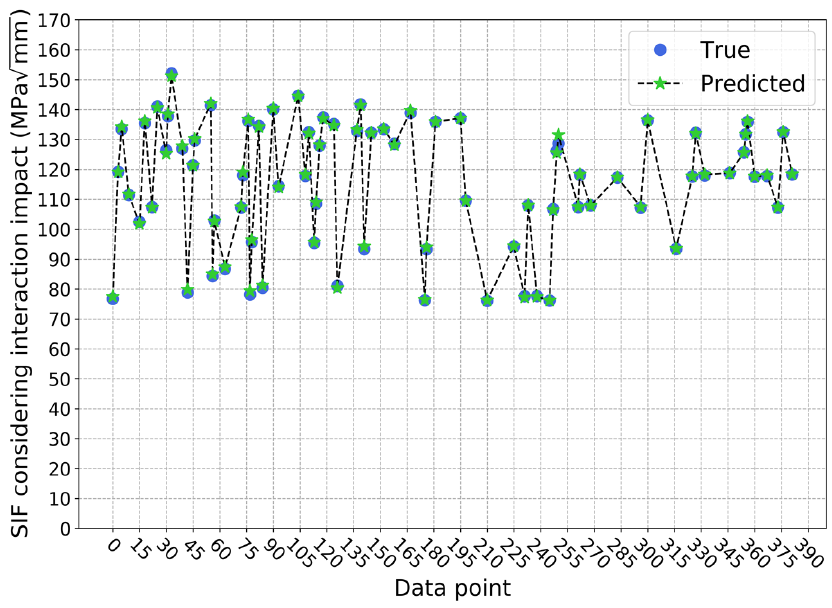
Figure 9. Prediction results of SIF values without considering interaction impact based on approach 2.